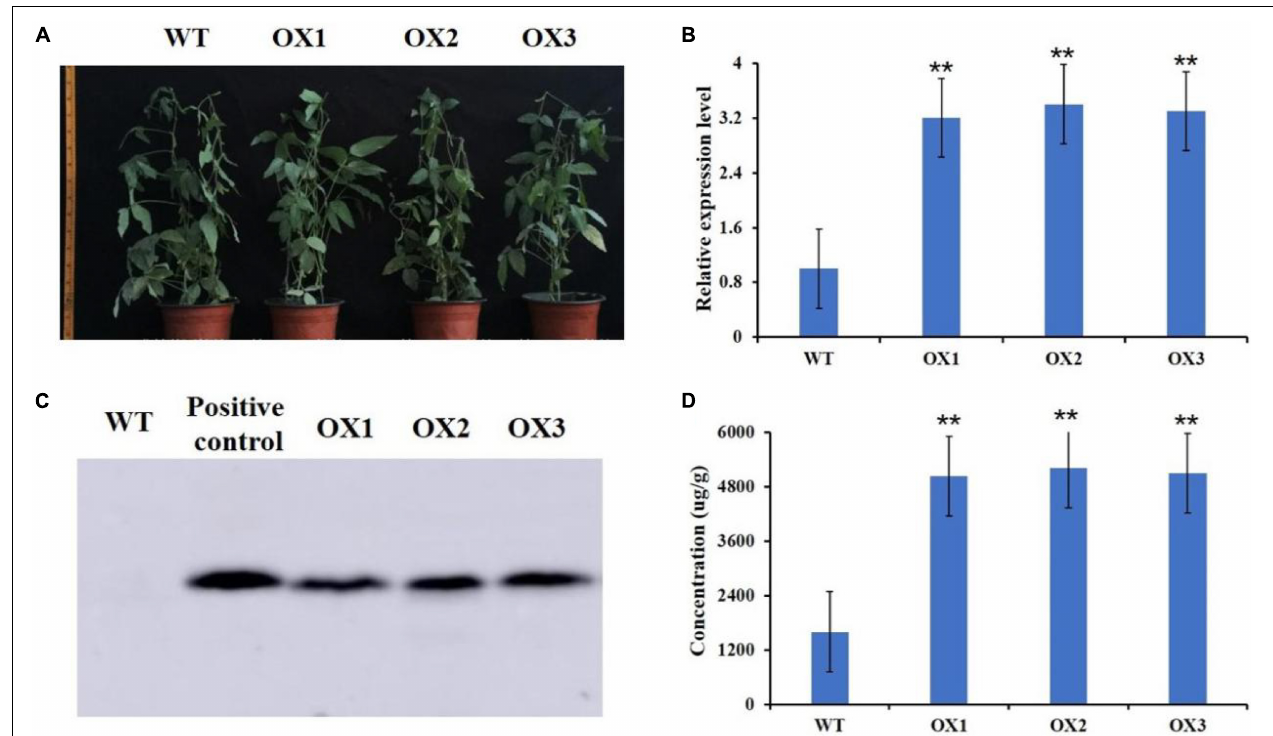
FIGURE 5 | Overexpression GmMT1 in the soybean cultivar “Dongnong50” (WT). (A) WT Dongnong plants and T2 transgenic plants overexpressing GmMT1 (OX1–3). (B) Relative GmMT1 expression in WT and T2 transgenic plants. (C) Western blot showing the expression of the bar protein in the transgenic soybean plants. (D) Isoflavone contents in the seeds produced by the WT and transgenic soybean cultivars. ** indicates a significant difference between WT and transgenic soybean plants ( P < 0.01, Student’s t -test. Error bars represent the standard error, n =